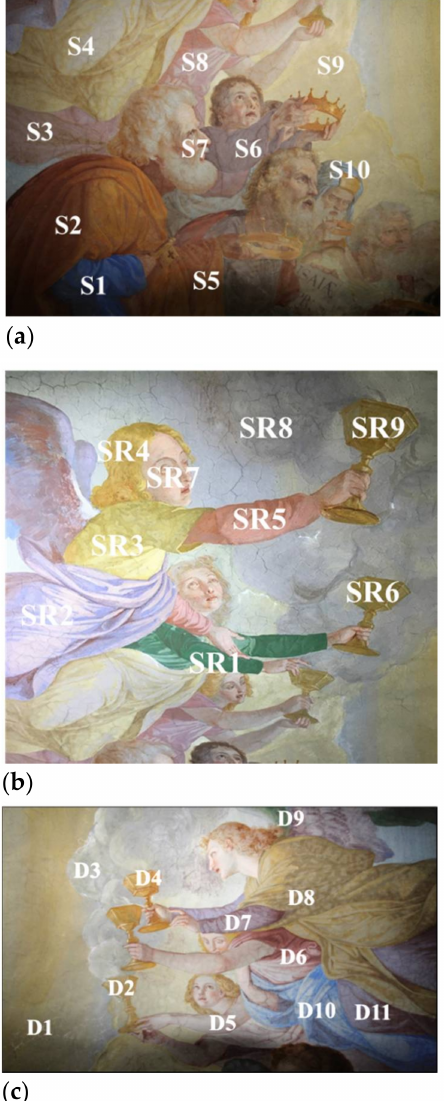
Figure 2. Areas measured by means of Full Range VIS/NIR/SWIR spectroscopy ( a – c